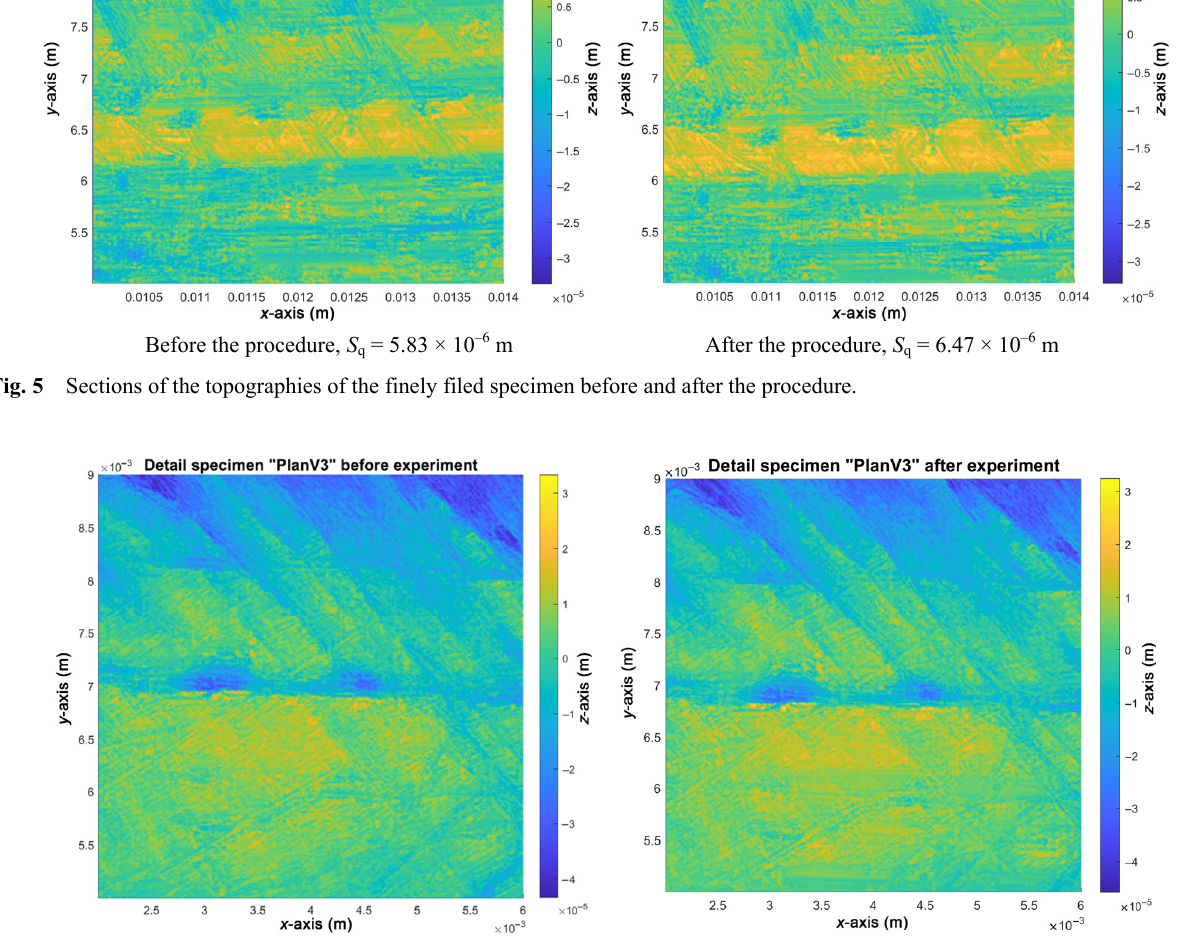
Before the procedure, S q = 1.02 × 10 –5 m Fig. 6 Sections of the topographies of the coarsely filed pin before and after the